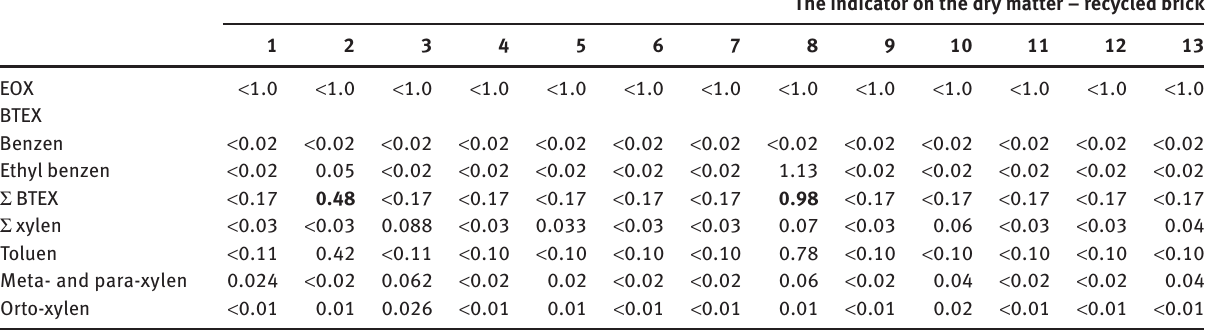
The indicator on the dry matter – recycled